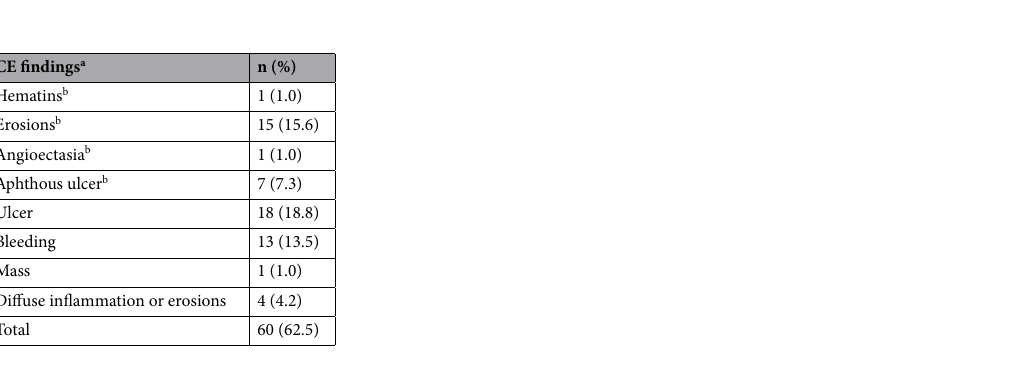
Table 3. Main endoscopic findings of the validation set (n = 96). CE, capsule endoscopy. a Classified as a